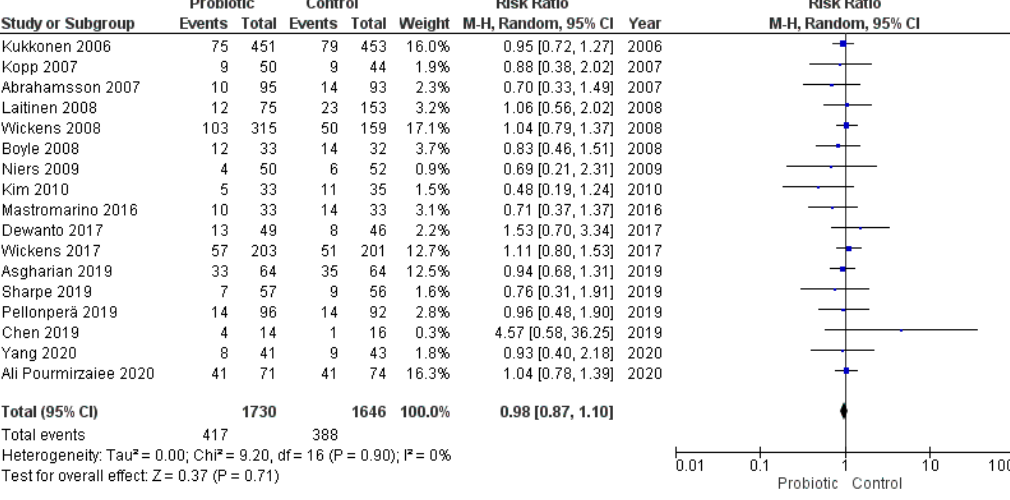
Figure 10. Meta-analysis of studies evaluating the administration of probiotic and cesarean section.